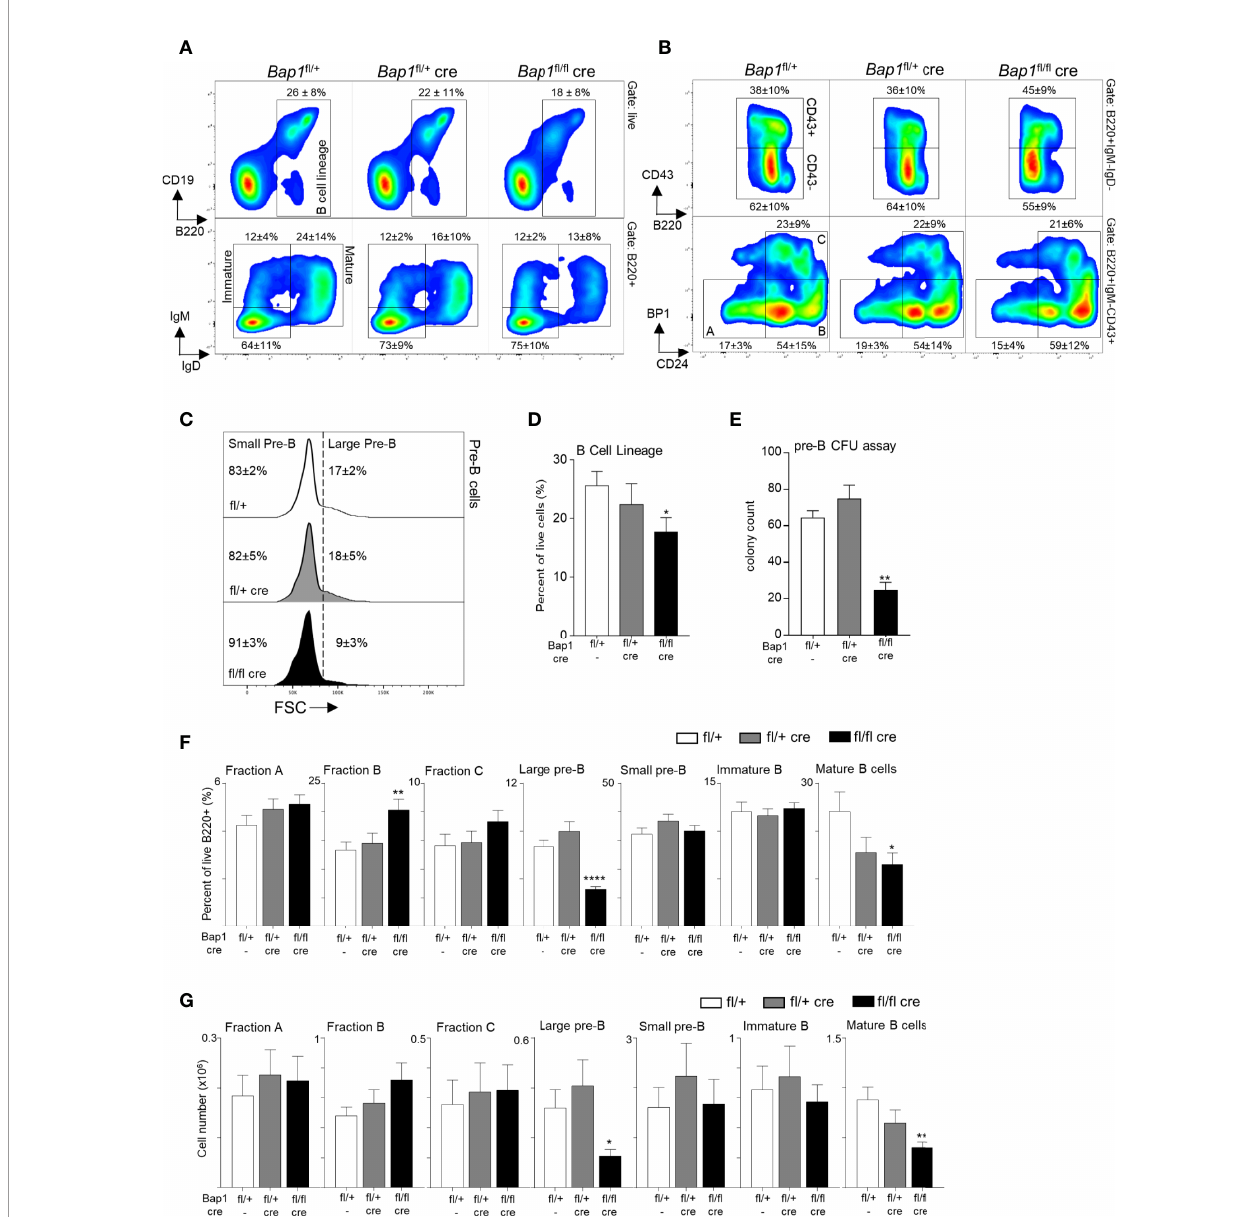
FIGURE 2 | BAP1 loss impairs B cell development from the pre-B cell stage in the bone marrow. (A, B) Representative fl ow cytometry plots of the bone marrow of mice of Bap1 fl /+ , Bap1 fl /+ Cre , and Bap1 fl / fl Cre genotypes, demonstrating: ( A , top) gating on B cell lineage cells (B220 + ); ( A , bottom) gating on mature B cells (IgM + IgD + ) and immature B cells (IgM + IgD - ); ( B , top) gating on pre-B cells (B220 + IgM - IgD - CD43 - ); ( B , bottom) gating on Hardy Fractions A, B and C cells as B220 + IgM - IgD - CD43 + , followed by CD24 and BP1 markers. Numbers indicate mean ± S.D. of cell frequency in each gate; data is from 10-12 mice per genotype, consolidated across 3 independent experiments. (C) Representative fl ow cytometry histograms gated on B220 + IgM - IgD - CD43 - pre-B cells, and showing the gating on large and small pre-B cell subsets based on the forward scatter (FSC) of the cells. Numbers indicate mean ± S.D. of cell frequency in each gate; data is from 10-12 mice per genotype, consolidated across 3 independent experiments. (D) Reduced frequency of B lineage cells (B220 + ) in the bone marrow of Bap1 fl / fl Cre relative to control mice. Data is from 10-12 mice per genotype, consolidated across 3 independent experiments. (E) Reduction in pre-B cell colony forming units in the bone marrow of Bap1 fl / fl Cre relative to control mice, demonstrating impaired B